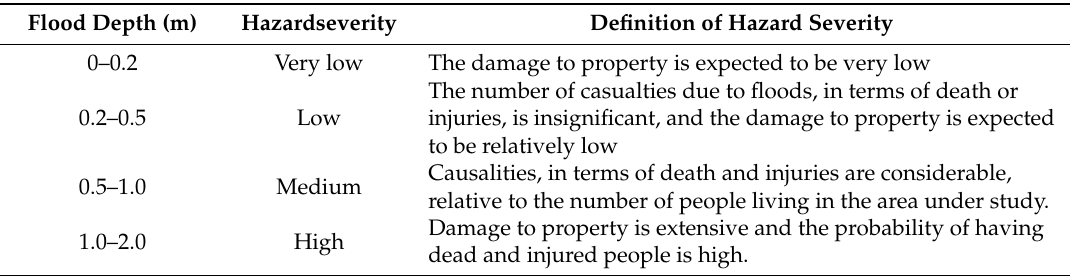
Table 7. Categorization of flood hazard severity [36].